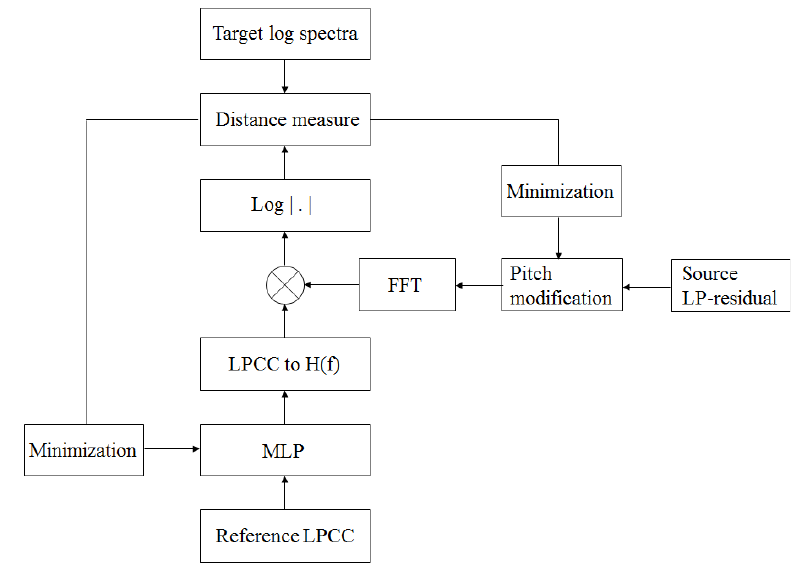
Figure 3. Block diagram of constructing of the conversion parameters.